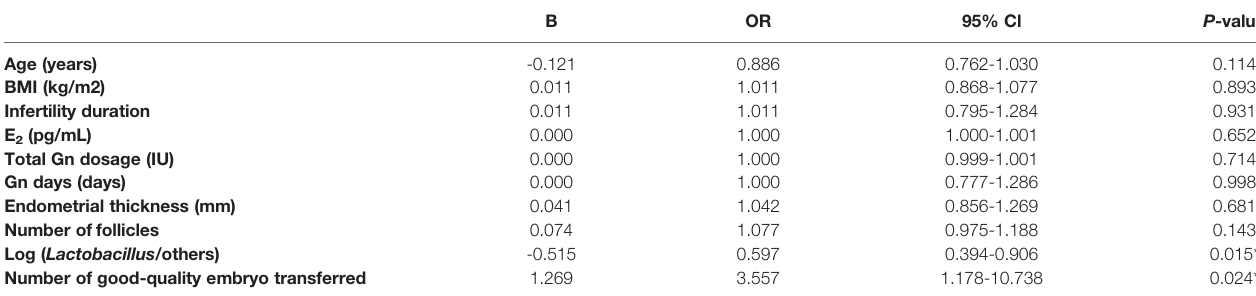
TABLE 3 | Univariate logistic regression assessing the association of clinical factors and microbiota composition with clinical pregnancy. B OR 95% Cl